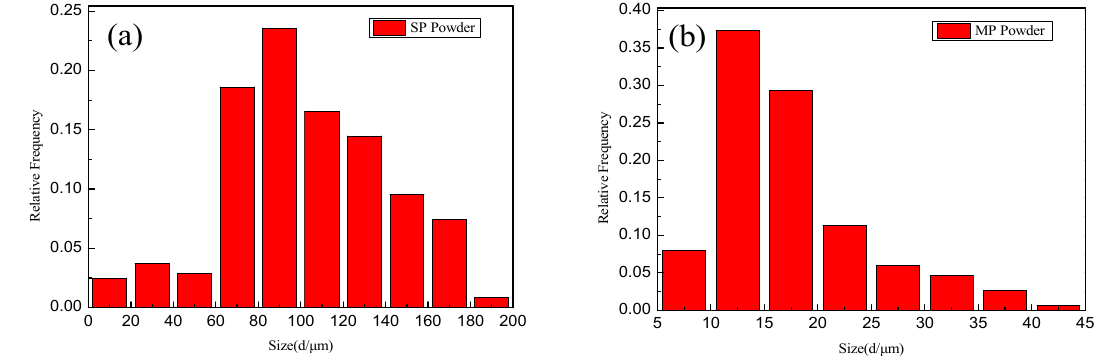
Figure 2. Particle size distribution of Ti-48Al-2Cr-8Nb powder. ( a ) SP powder and ( b ) MP powder.